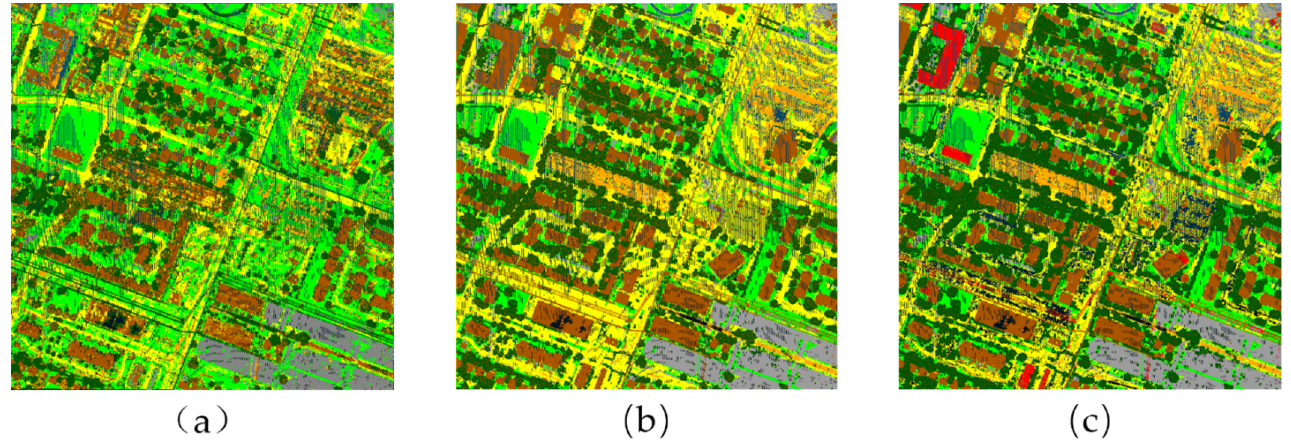
Figure 8. ( a ) The intensity combination classification results for the 1064 nm and 1550 nm channels, ( b ) the intensity combination classification results for the 1550 nm and 532 nm channels, ( c ) the intensity combination classification results for the 1064 nm and 532 nm channels. Table 4. Classification results by the random forest classifier.